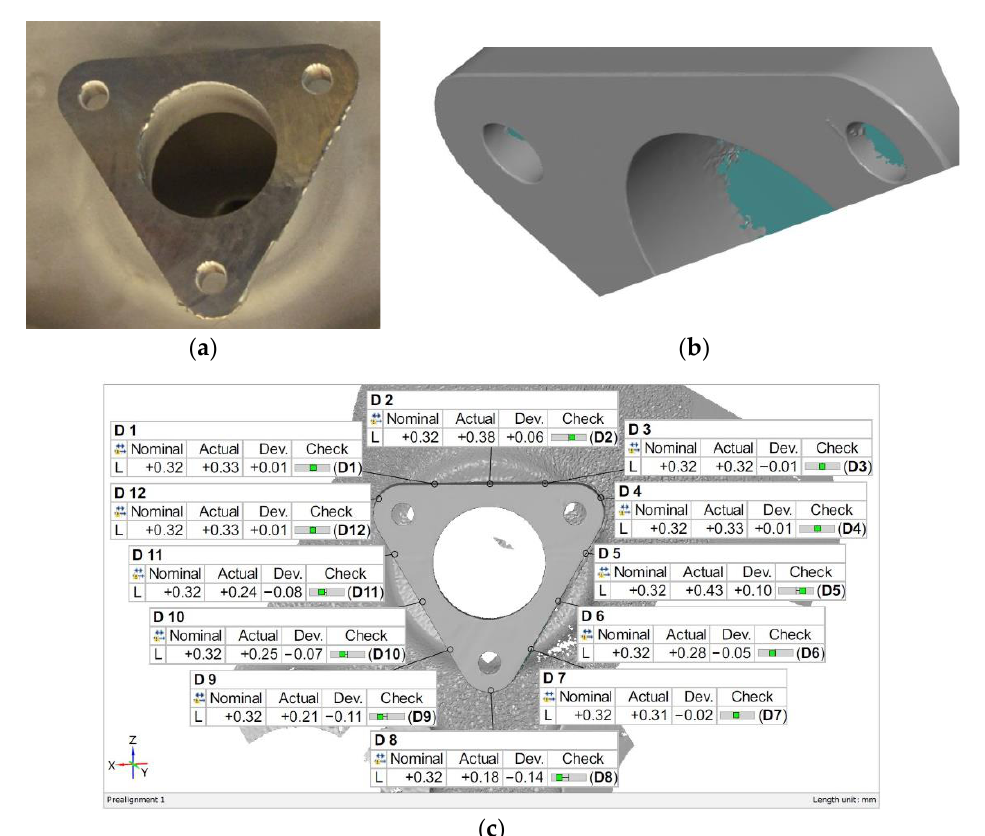
Figure 21. Deburred boss: ( a ) before the process; ( b ) after the process; ( c ) measurement of the obtained chamfer.